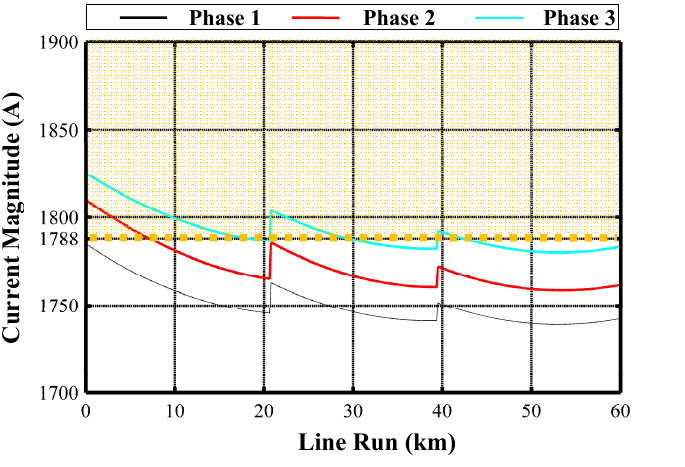
Figure 14. Phase current magnitudes along the compensated single-circuit cable in CB without PTs.